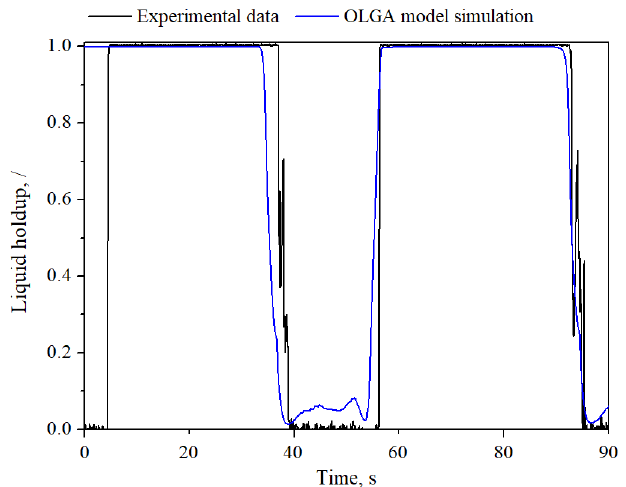
Figure 19. Experimental and simulated profile of liquid holdup in severe slugging ( U GS = 0.08 m/s and U LS = 0.09 m/s). and U LS = 0.09